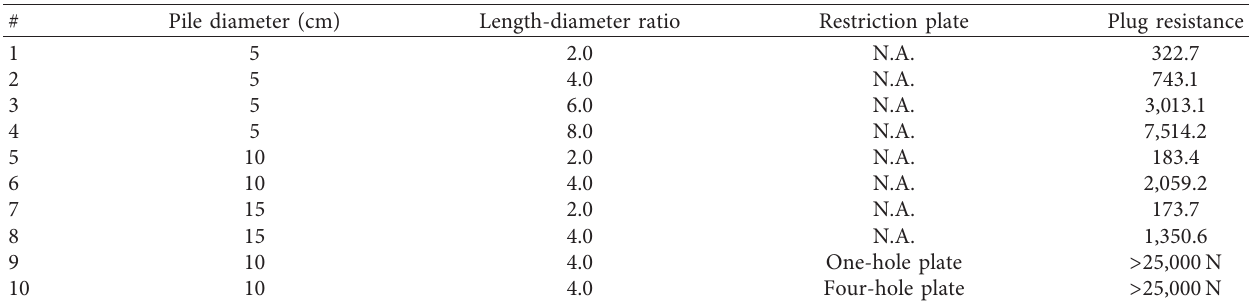
Table 3: Geometric dimensions of soil plug models used in laboratory